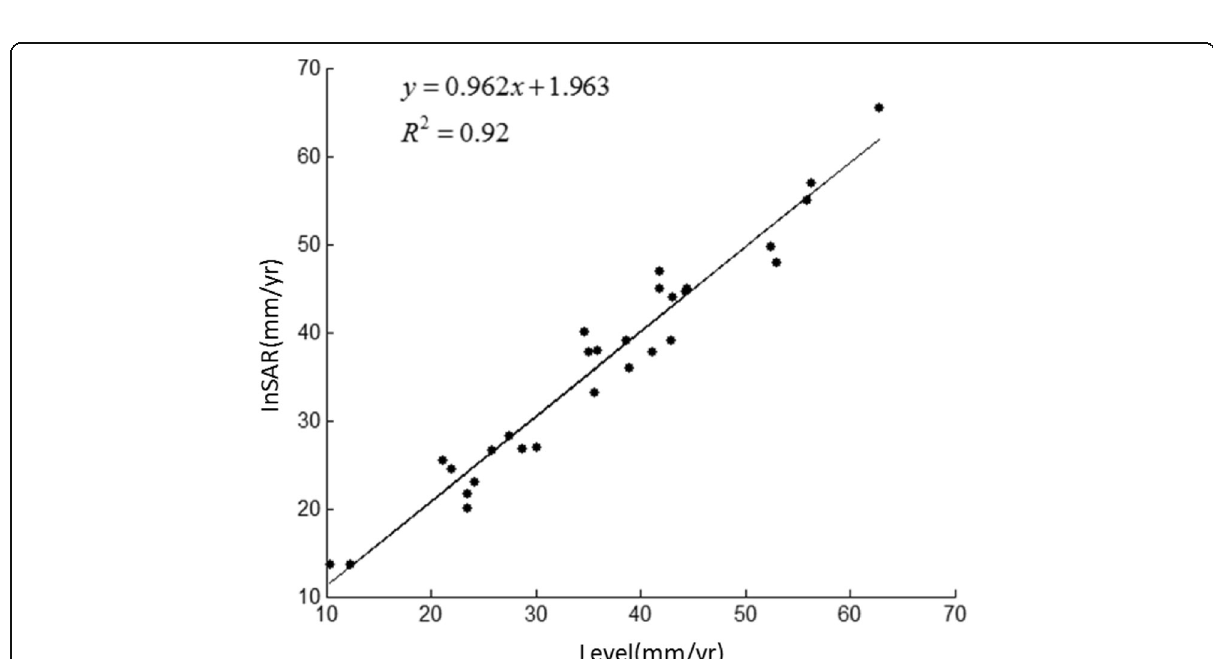
Fig. 7 Correlation been InSAR and level observation